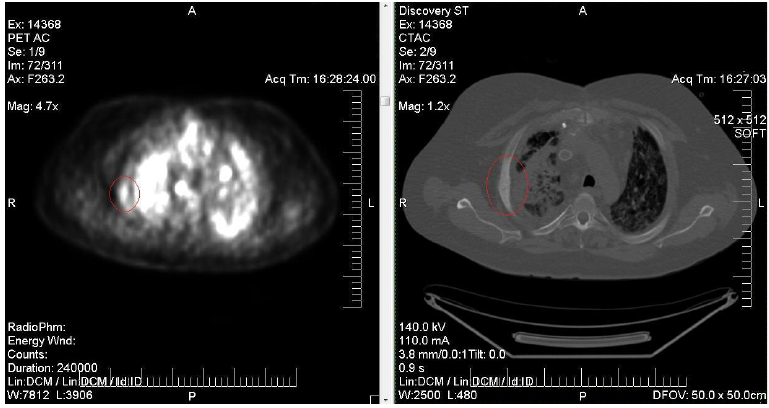
Figure 3. Mild abnormal hypermetabolism in fusiform fashion of the right third lateral rib. Additional non- osseous regions of hypermetabolism are seen corresponding to pathologically enlarged mediastinal and hilar lymph nodes.